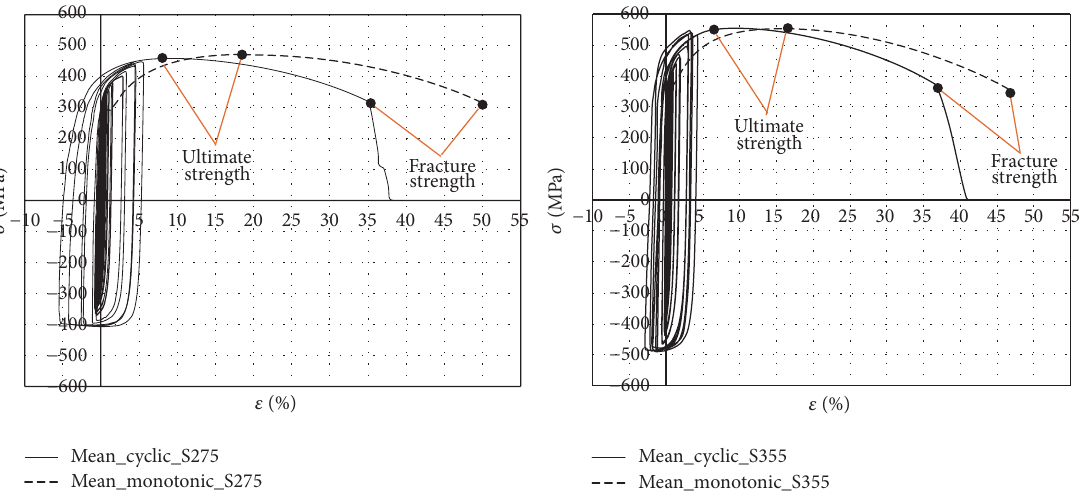
Figure 7: Comparison between monotonic loading stress-strain curves and hysteresis stress-strain curves.